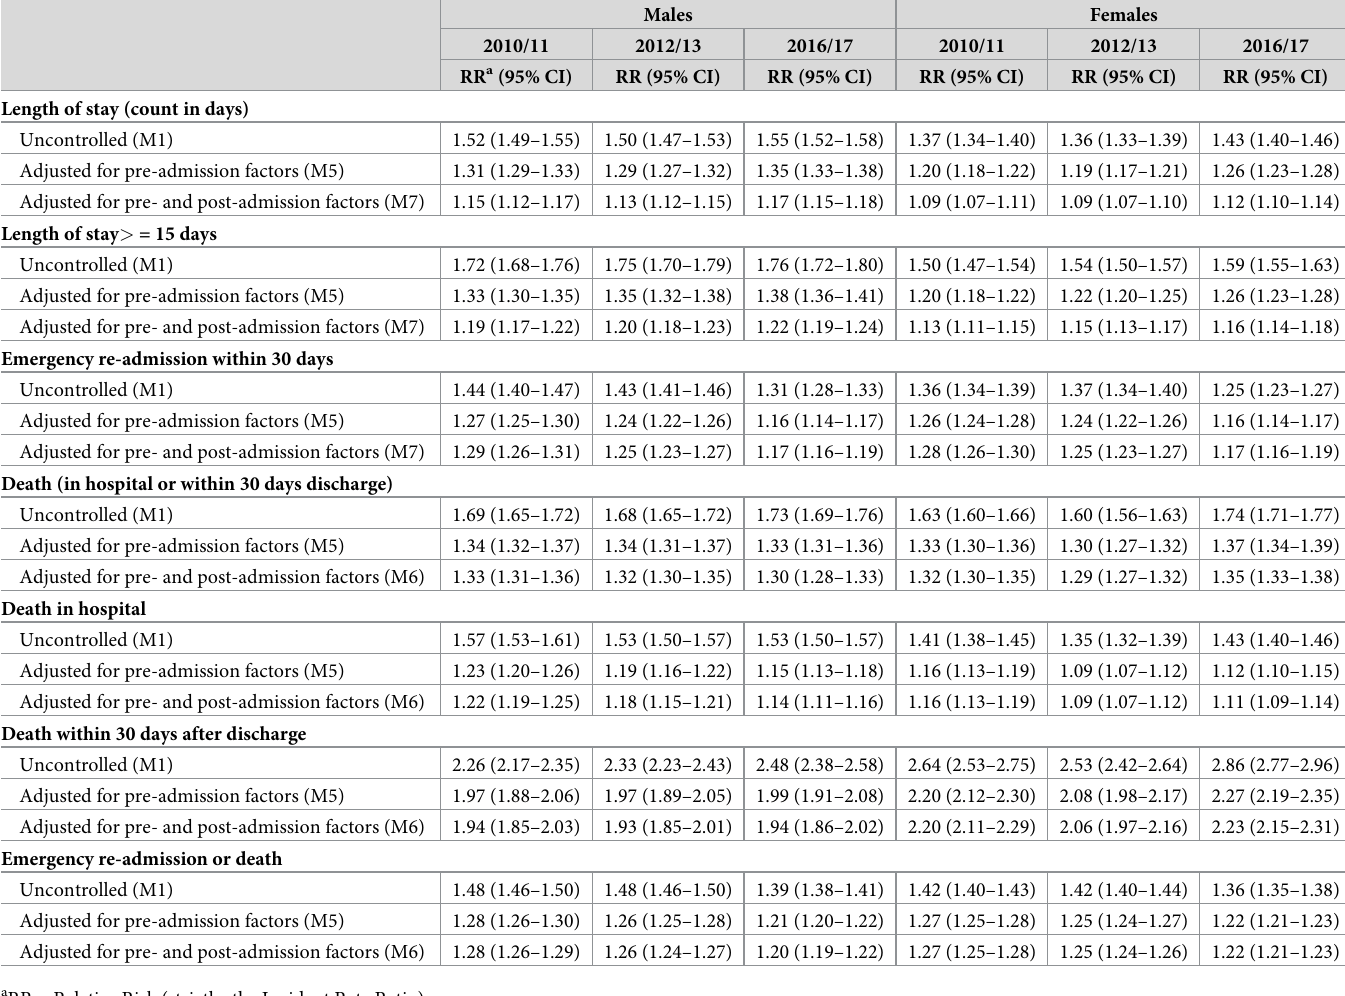
Table 4. Summary of group comparisons from hierarchical regression